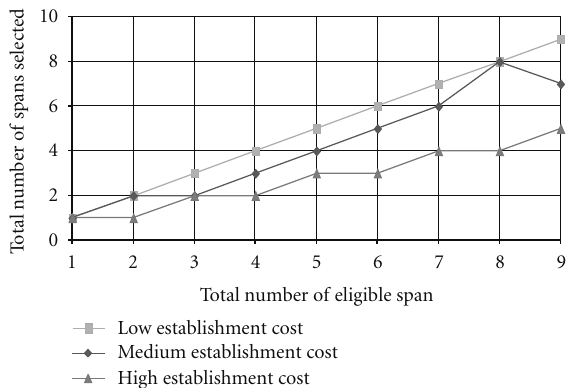
Figure 9: Variation of total number of selected spans for 10-node 20-span network.